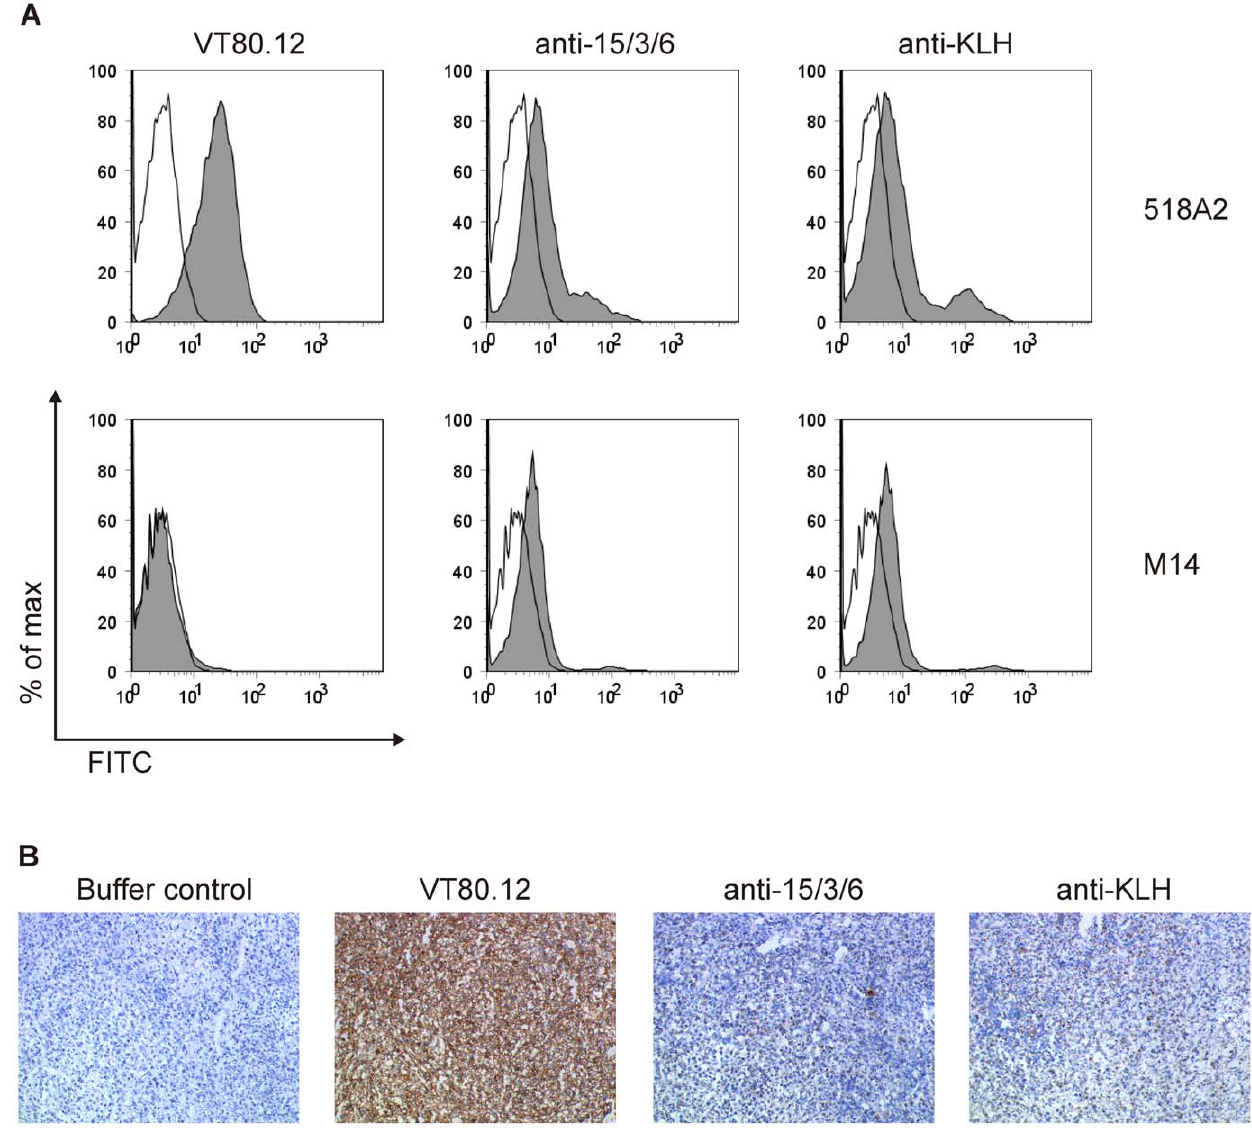
Figure 3. HMW-MAA-specific Ab response determined by FACS and IHC. ( A ) The human melanoma cell lines 518A2 and M14 were each incubated with 1 m g mAb VT80.12 (as positive control to detect HMW-MAA) or 100 m g purified rabbit IgG from immunizations with 15/3/6-KLH conjugate or KLH. Bound IgG were detected with FITC-labeled goat anti-mouse IgG or FITC-labeled goat anti-rabbit IgG. Histogram overlays show unstained (white) vs. stained cells (grey). ( B ) IHC on 518A2 tumor tissues of C.B.17 SCID/SCID mice [13]. HMW-MAA staining was done with PBS buffer (negative control), mAb VT80.12 (positive control), and biotinylated IgG purified from rabbits immunized with 15/3/6-KLH conjugate (anti-15/3/6) or KLH (anti-KLH). Bound Abs were detected with StrepAB/HRP and visualized by DAB-chromogen solution and subsequent hematoxylin counterstaining.